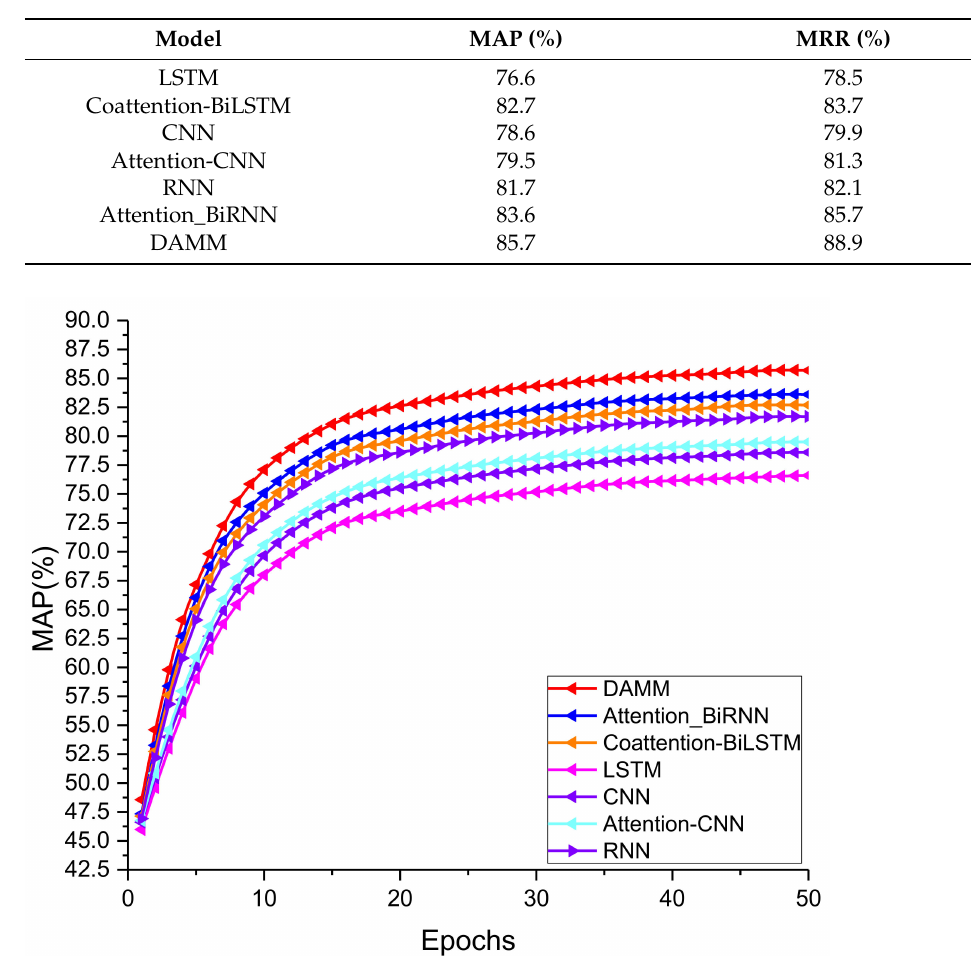
Figure 4. Comparison of the MAP with seven answer selection